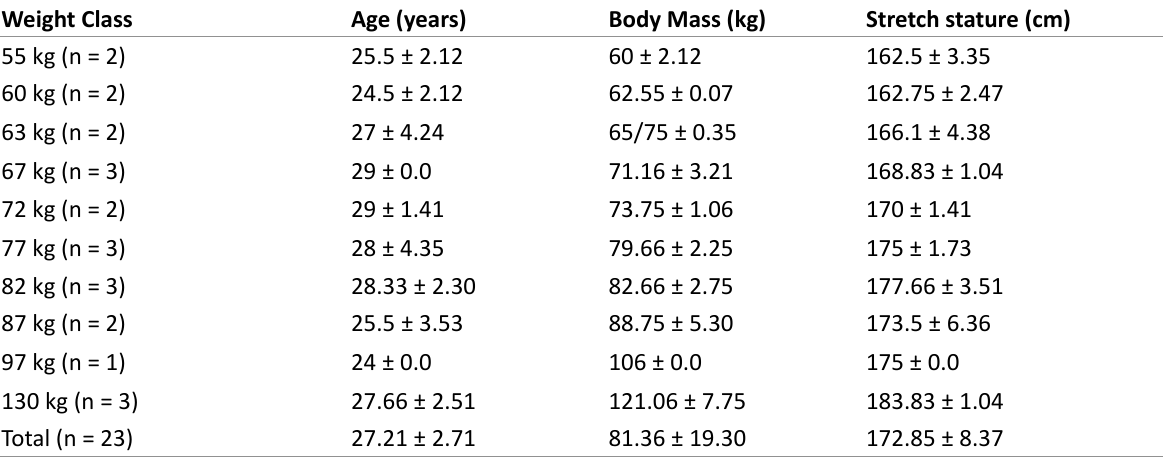
Table 1. Mean and standard deviation of individual characteristics of the elite Azerbaijani senior Greco-Roman wrestlers